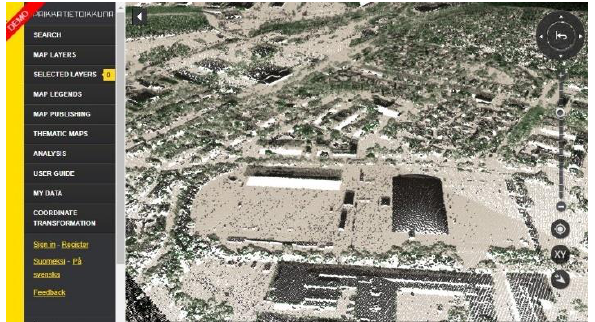
Figure 8 Kuopio city point cloud